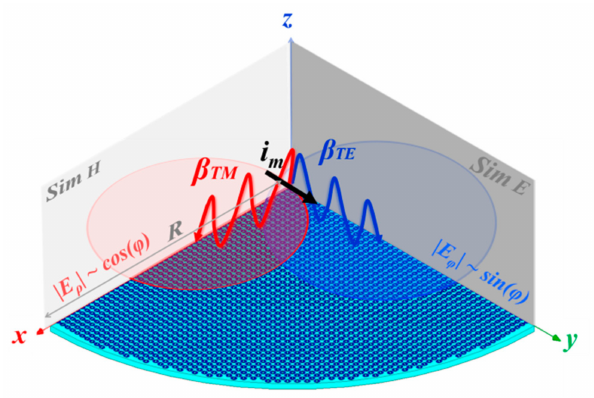
Figure 1. A rotationally symmetric metasurface is excited by a magnetic dipole oriented towards the y -axis: TM and TE SWs propagate radially on the surface phase synchronized. |E ρ | follows a cos( ϕ ) function while |E ϕ | follows a sin( ϕ ) function.